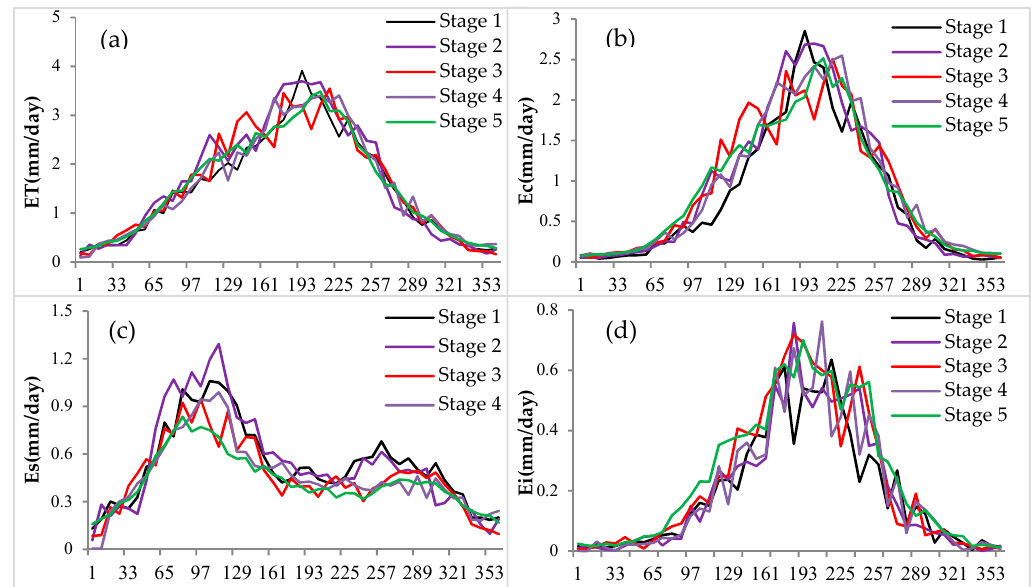
Figure 7. Temporal trends of daily ET( a ), Ec( b ), Es( c ), and Ei( d ) during different impoundment periods.